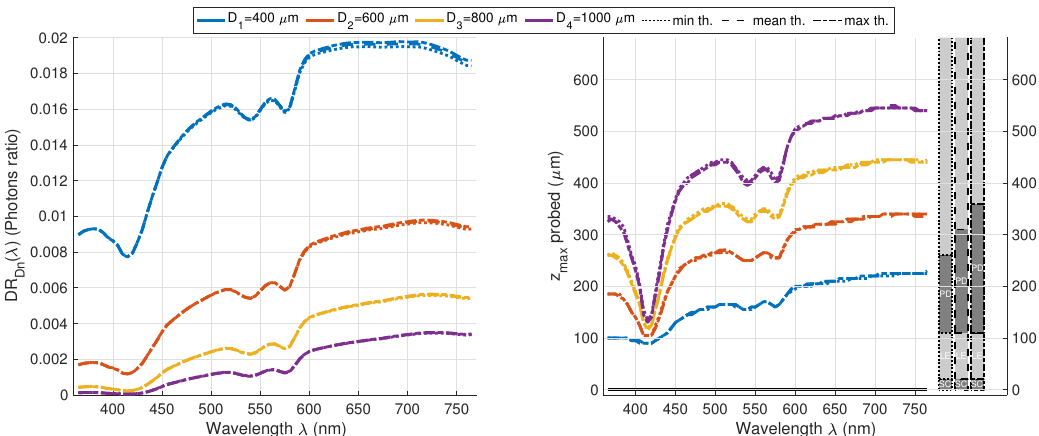
Figure 7. DR spectra ( left ) and maximum probed depth ( right ) for the thin (dotted line), mean (dashed) and thick dermal thickness media (dashed-dot). The SD distance D n is indicated by the color code. The three right columns represent the position of the border between the layers of each skin model (thin, mean, thick).